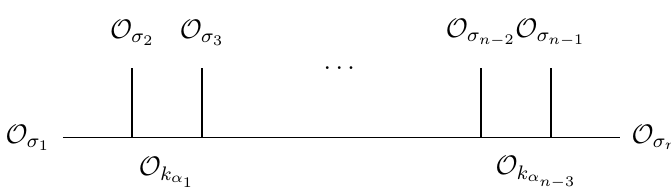
Figure 4 . The comb structure ( n ≥ 4 ) from which one v -type conformal cross ratio can be built. It should be understood that O